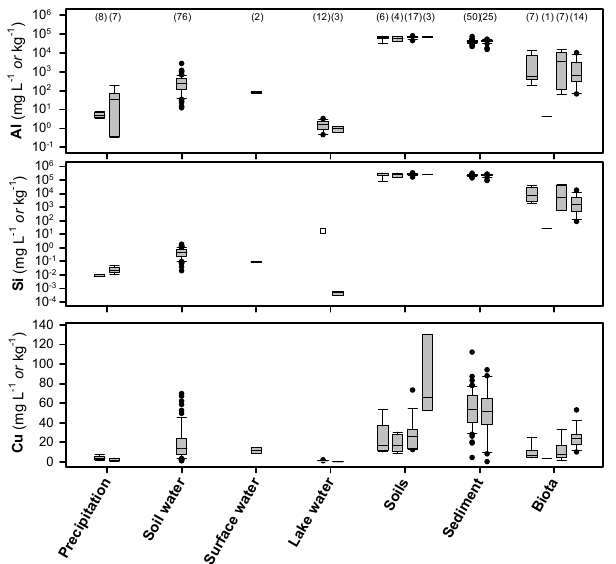
Figure 12. Box plot showing the concentrations of aluminum, sili- con and copper in different sample types (the concentrations are ex- pressed in mgL − 1 for water samples and in mgkg − 1 for solid sam- ples). The two boxes for precipitation represent rain (left) and snow (right). The two boxes for lake water represent lake water (left) and suspended matter (right). The four boxes for soils represent (from left to right) silt, O horizon, peaty-silt active layer and peaty-silt per- mafrost. The two boxes for sediments represent samples collected from water depths <14m (left) and >14m (right). The four boxes for biota represent (from left to right) terrestrial primary producers, terrestrial consumers, aquatic primary producers and aquatic con- sumers. The boxes denote the median and the 25th and 75th per- centiles, while the whiskers denote the 10th and 90th percentiles. Outliers are marked with a black dot, and the open squares mark that all analysed samples were below the detection limit. The num- bers within parenthesis represent the number of samples that were analysed for each sample type.